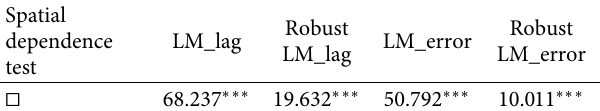
Table 7: Spatial correlation test results.